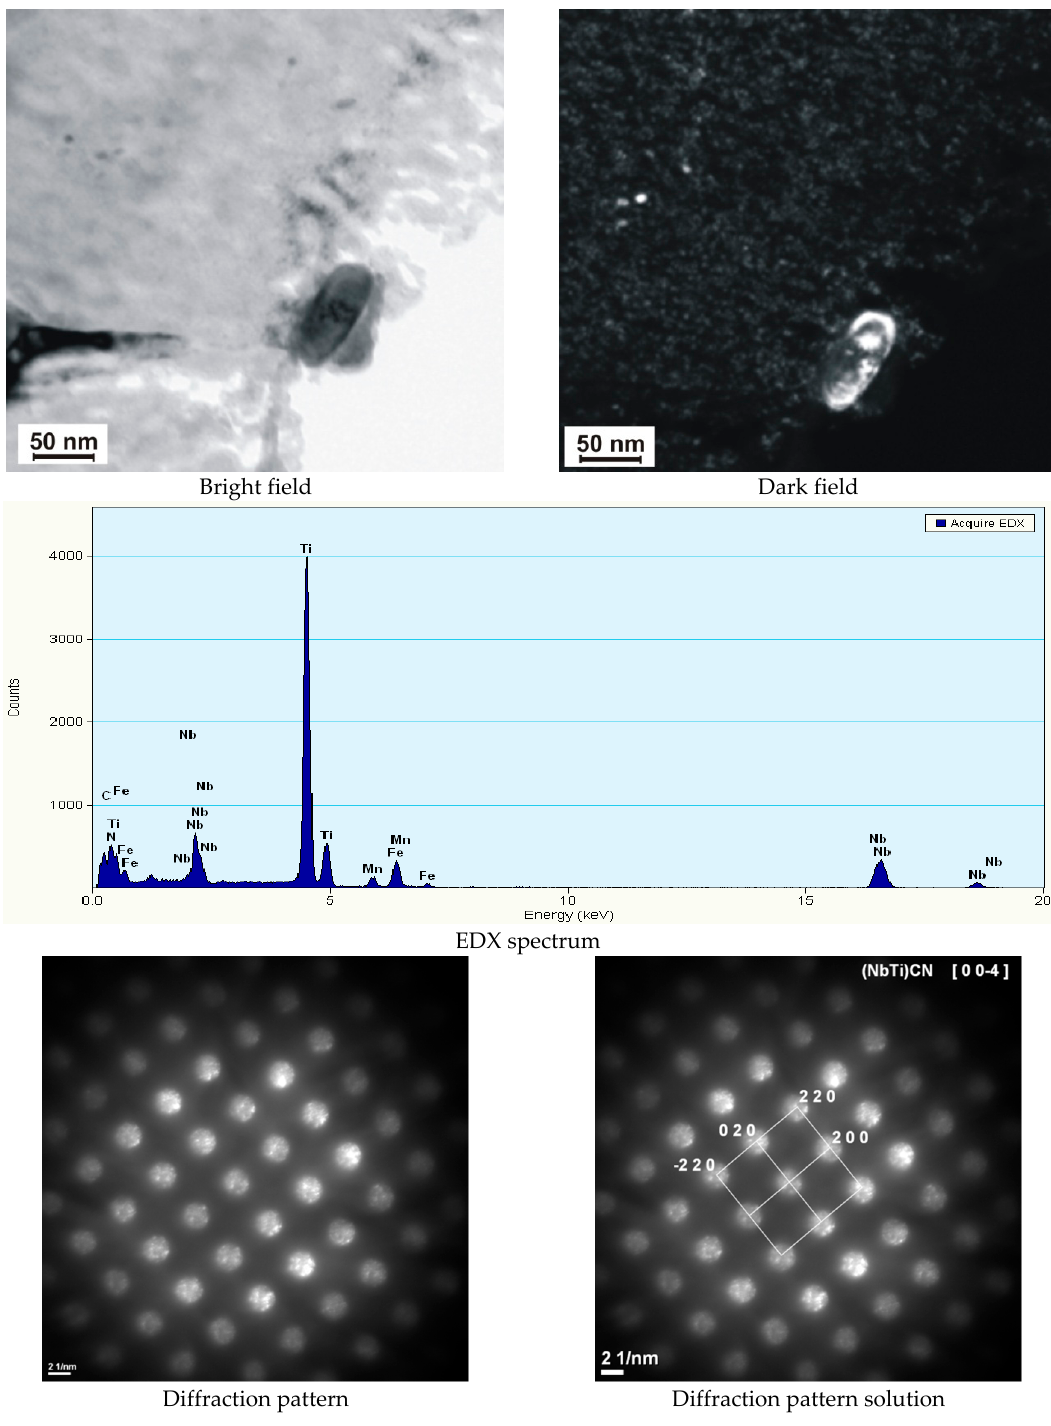
Figure 3. Carbonitride (Ti,Nb)(C,N) with small spherical precipitates responsible for the precipitation hardening of steel S700MC.